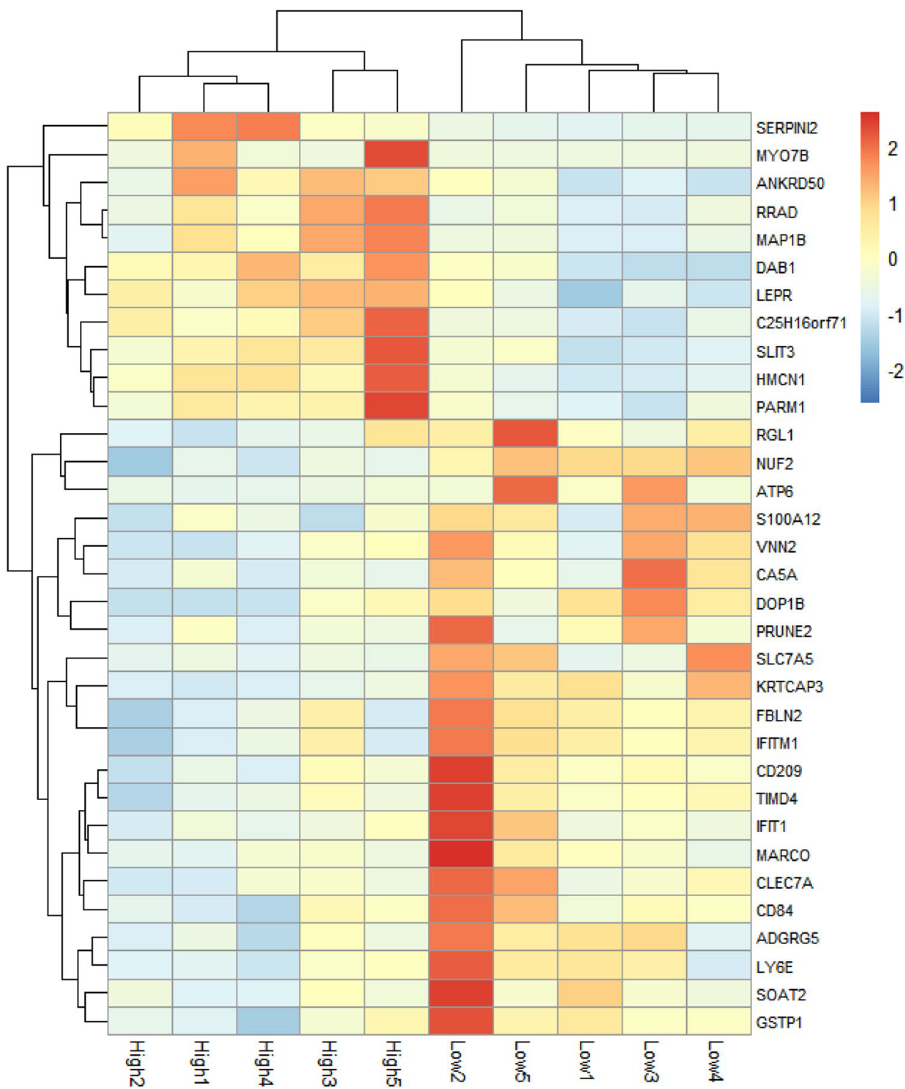
Figure 4. Heat map illustrating the hierarchical cluster of differentially expressed genes in HME vs LME in late fattening phases. HME: group of high methane emission cattle (n = 5), LME: group of low methane emission cattle (n = 5).